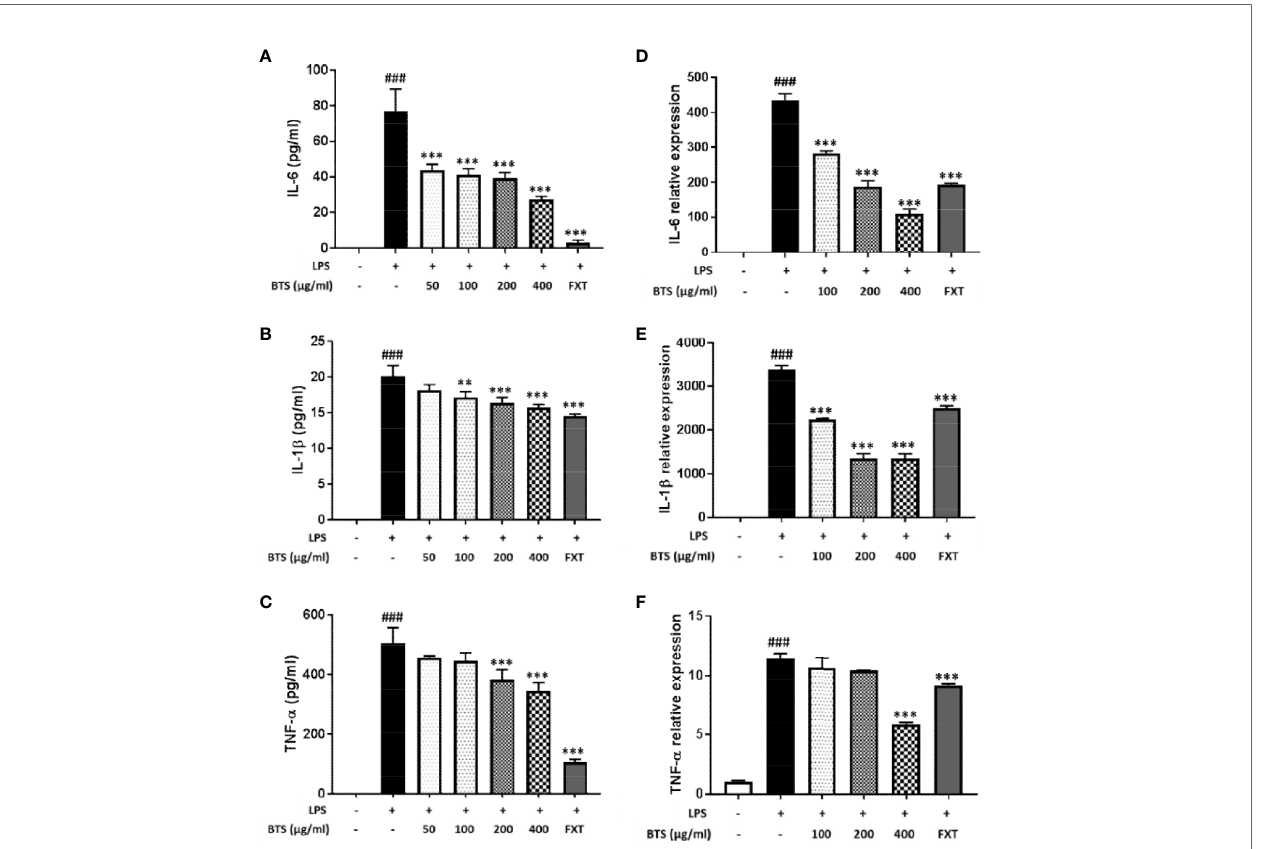
FIGURE 6 | Effect of BTS on expression of pro-in fl ammatory cytokines in BV2 cells. BV2 cells were pretreated with BTS for 1 h and then stimulated with LPS (100 ng/ml) for 6 h. mRNA expression levels of (A) Il6 , (B) Il1b , and (C) Tnfa were determined by real-time PCR. Gapdh was used as a loading control. BV2 cells were pretreated with BTS for 1 h and then stimulated with LPS (100 ng/ml) for 16 h. Levels of (D) IL-6, (E) IL-1 b , and (F) TNF- a in the cell culture supernatant were measured by ELISA. The data represent the mean ± SD of triplicate determinations (one-way ANOVA: ### p < 0.001 vs. untreated control; **p < 0.01, ***p < 0.001 vs. LPS-treated